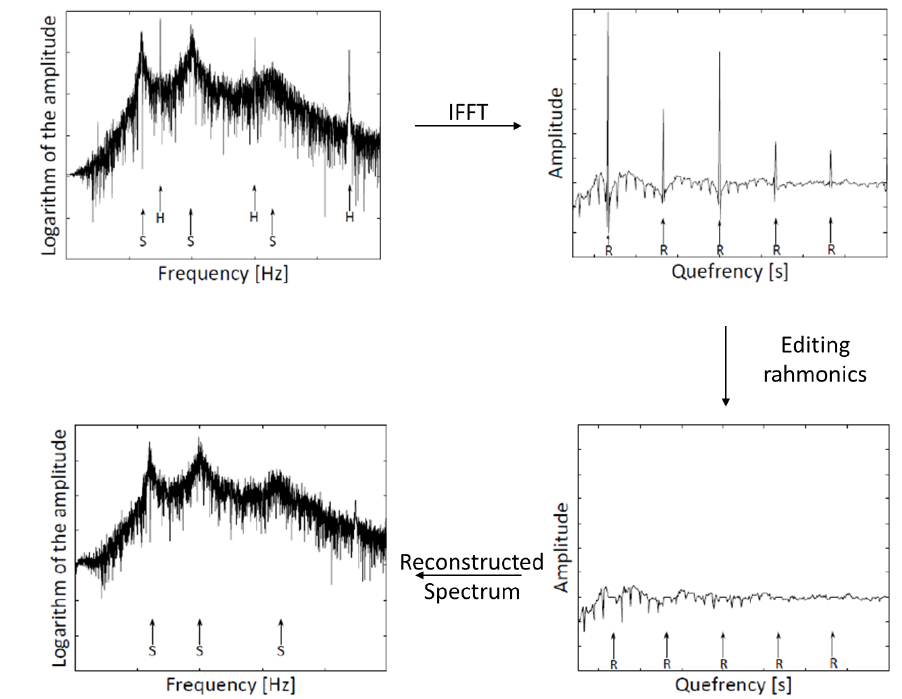
Figure 12. Cepstral method for removal of harmonics. The harmonics are indicated by H, the structural modes by S, and the rahmonics in the cepstral domain by R (Motte et al., 2015).